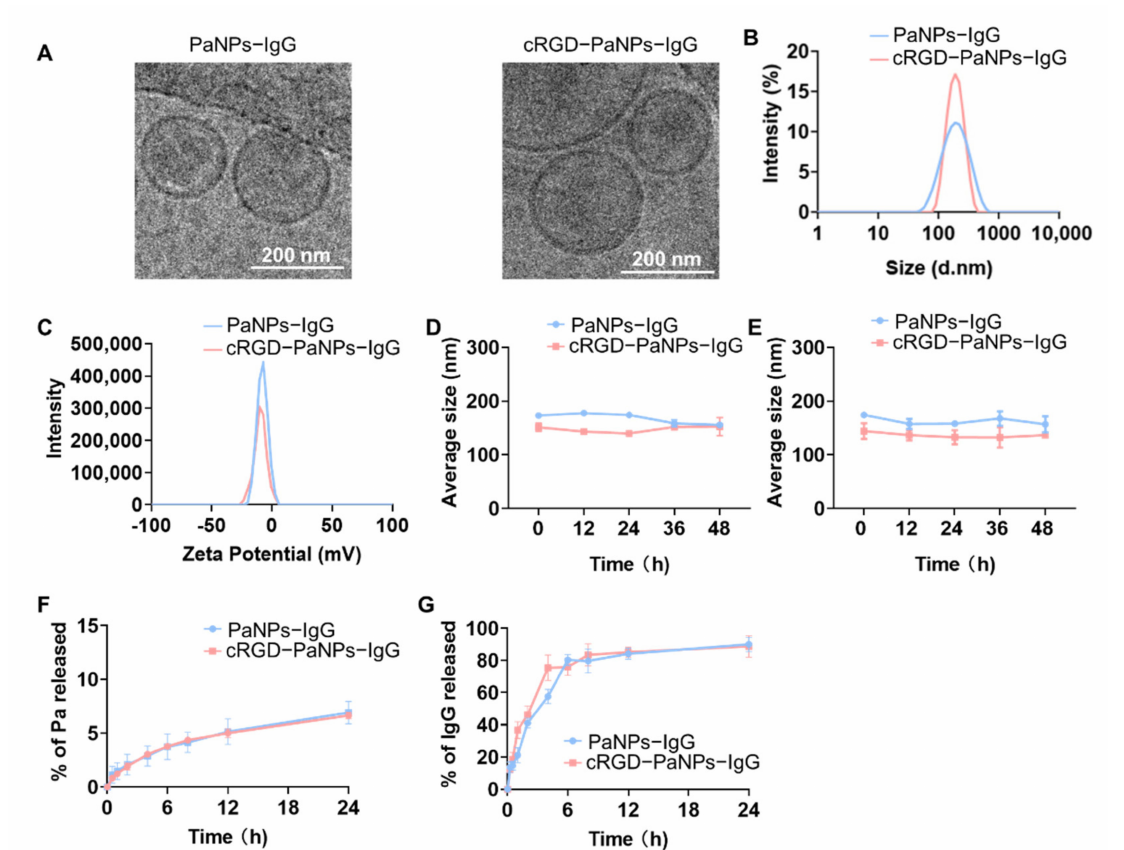
Figure 1. Characterization of PaNPs–IgG or cRGD–PaNPs–IgG. ( A ) The cryo–TEMs, ( B ) size distri- bution and ( C ) zeta potentials of PaNPs–IgG and cRGD–PaNPs–IgG, respectively. ( D ) Stability of the liposomes in PBS (pH = 7.4) for 48 h. ( E ) Stability of PaNPs–IgG or cRGD–PaNPs–IgG in PBS (pH = 7.4) containing 10% ( v / v ) FBS for 48 h. ( F ) Cumulative release of Pa from PaNPs–IgG or